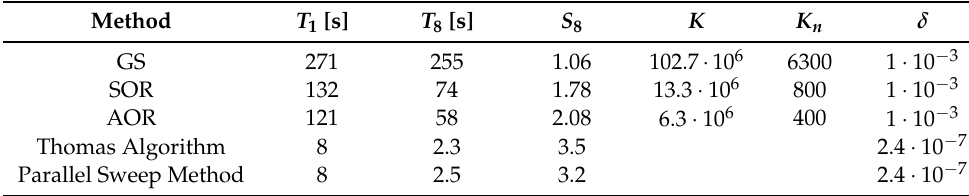
Table 1. Results of experiments for Problem